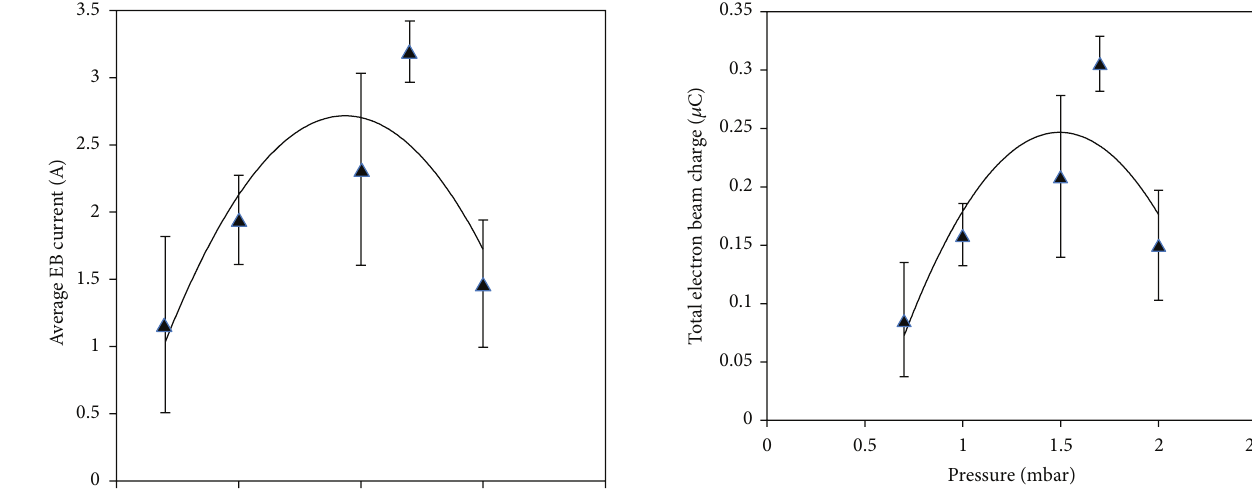
Figure 12: Variation of total electron beam charge versus Argon gas